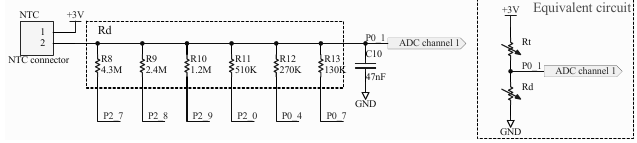
Figure 6. The voltage divider with controllable resistors. As can be seen from (3), the gradient of sampling result respect to temperature dN determined by the B-constant B , the reference voltage V ref , and the resistance of divider resistor R d . To improve the measurement gain, larger B and smaller V ref are